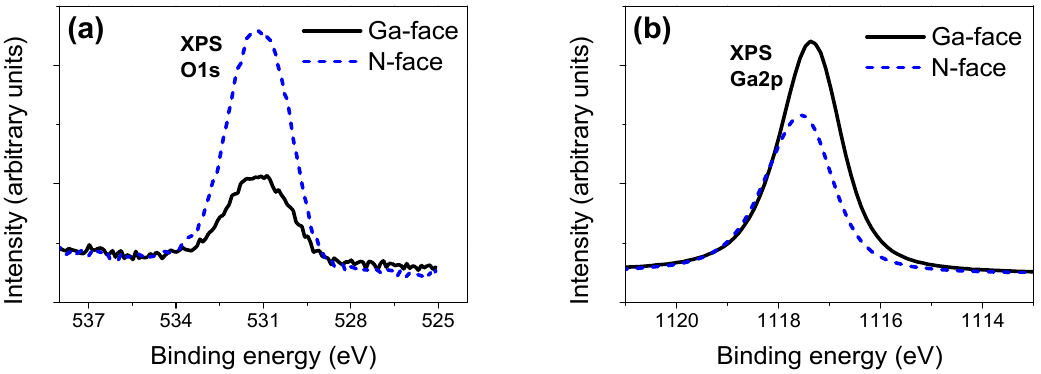
Figure 8. XPS analysis of the surfaces of Ga- and N-faced GaN samples. ( a ) Comparison of O1 s XPS spectra (core level of ~532 eV) on Ga-face and N-face. ( b ) Comparison of Ga2p XPS spectra (core level of ~1117 eV) on Ga-face and